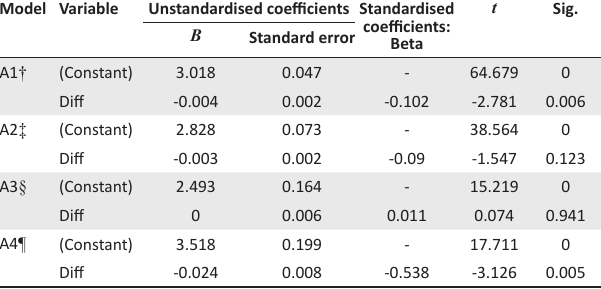
TABLE 4: Conditional regression result of creative talents (age). Model Variable